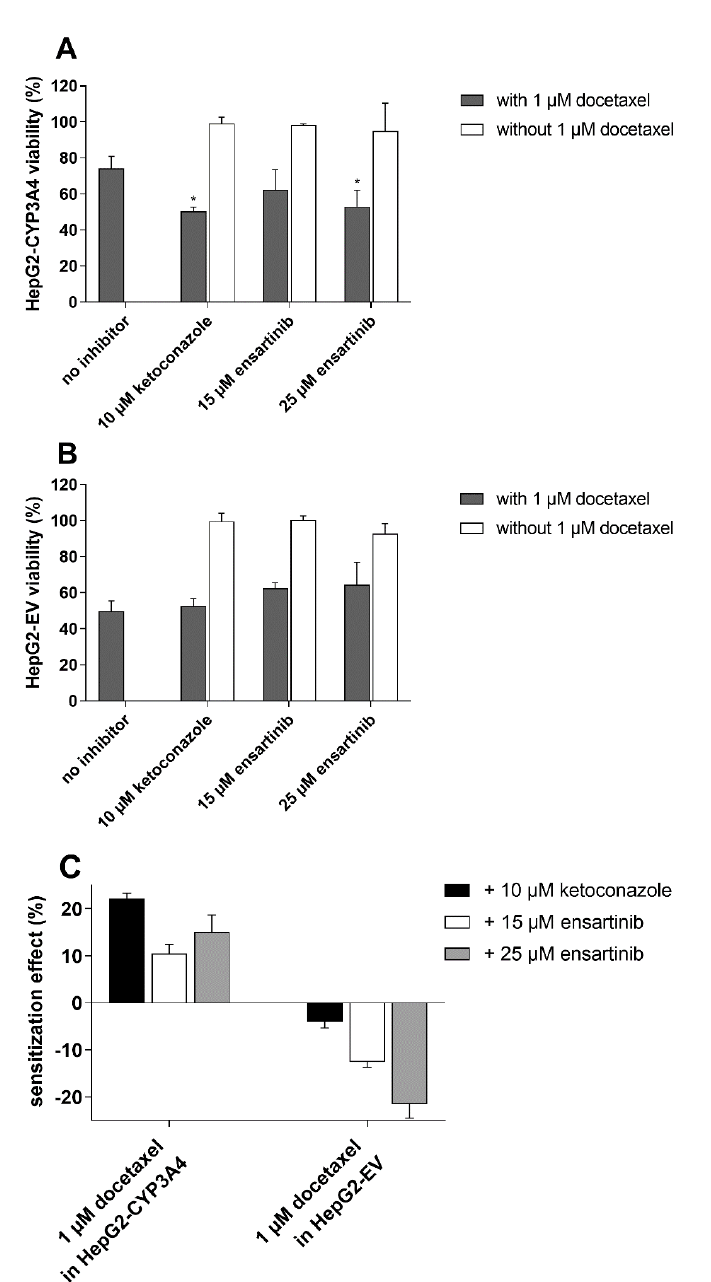
Figure 8. Effects of ensartinib (15 and 25 µM) and the model CYP3A4 inhibitor ketoconazole (10 µM) on the antiproliferative activity of 1 µM docetaxel in HepG2-CYP3A4 ( A ) and HepG2-EV ( B ) cells. Cells were exposed to the tested drugs alone or in tandem for 48 h, after which their viability was assessed using the MTT test. (C) Sensitization effects were computed using the data from viability measurements. Statistical analysis was performed using one-way ANOVA followed by Dunnett’s post hoc test (* p < 0.05 compared to no inhibitor). The plotted values are means ± SD for three independent experiments.